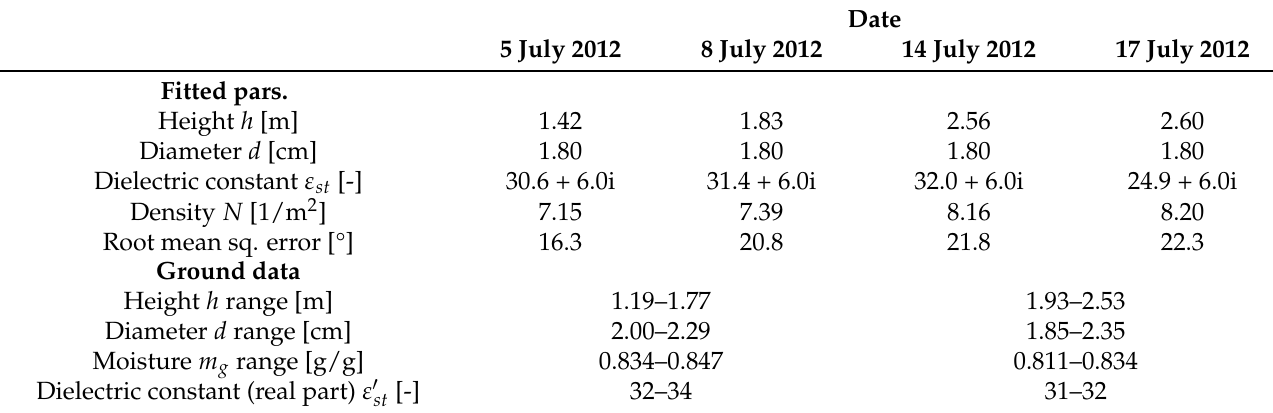
Table 2. Stalk features as compared to the fitting and to the ground data from dates prior to peak biomass. Field campaign in Canada with UAVSAR. The dielectric constant on ground data is estimated from stalk moisture by means of Mätzler’s model shown in Figure